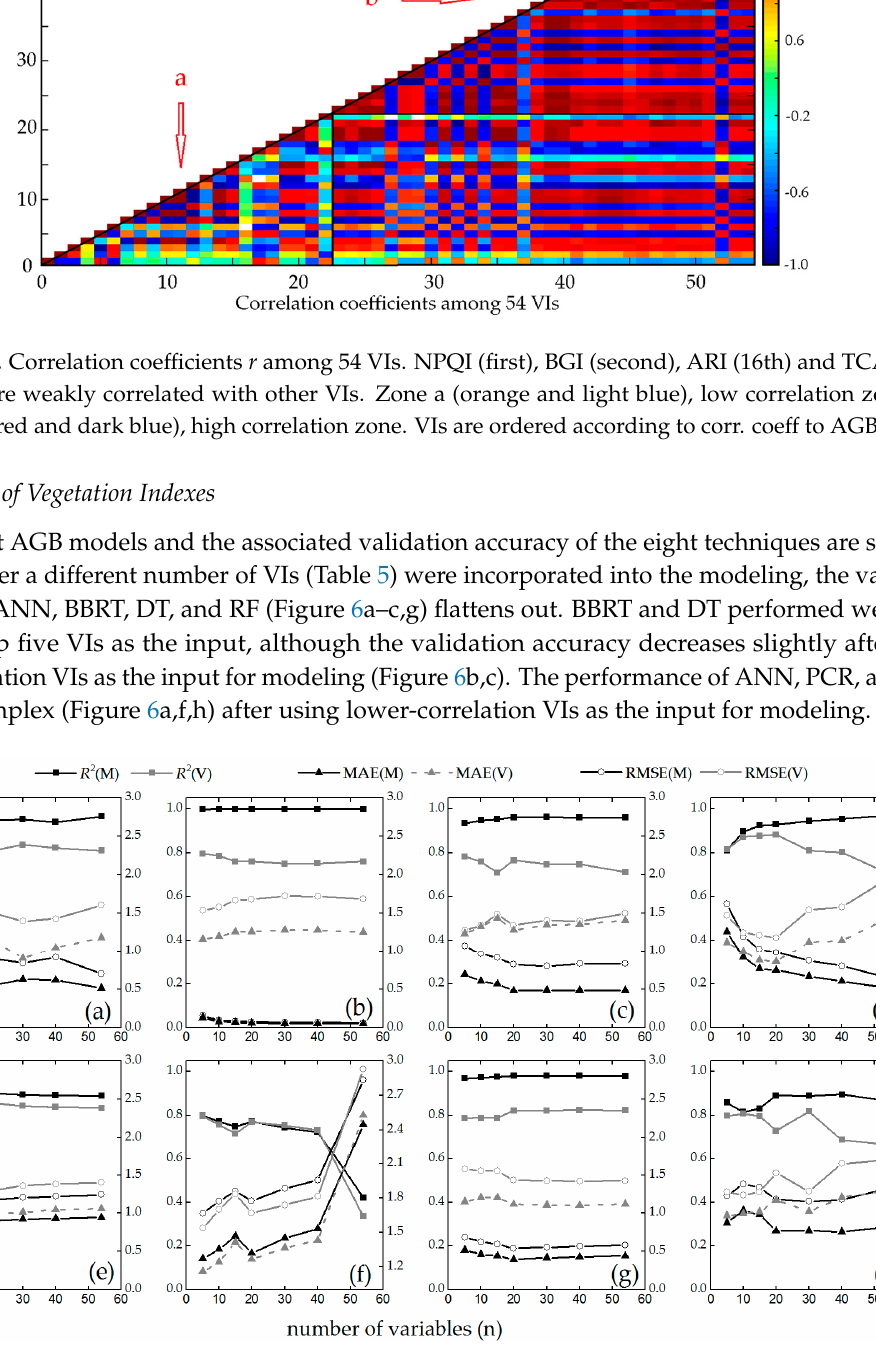
Figure 6. Best AGB modeling and validation accuracy for eight techniques with different input VIs: ( a ) ANN, ( b ) BBRT, ( c ) DT, ( d ) MLR, ( e ) PLSR, ( f ) PCR, ( g ) RF, ( h ) SVM. Note: R 2 (M) and R 2 (V) indicate R 2 for modeling and validation, respectively. The same notation is used for MAE (M) and MAE (V), RMSE (M), and RMSE (V).